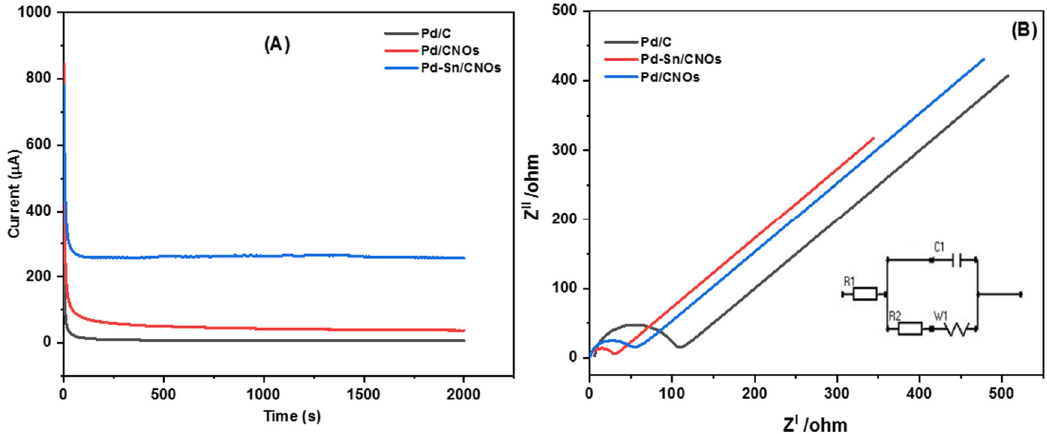
Figure 10. Chronoamperograms ( A ) and Nyquist plots with corresponding equivalent circuit ( B ) of Pd/C, Pd/CNO, and Pd-Sn/CNO electro-catalysts in 1 M KOH + 1 M CH 3 CH 2 OH solution.